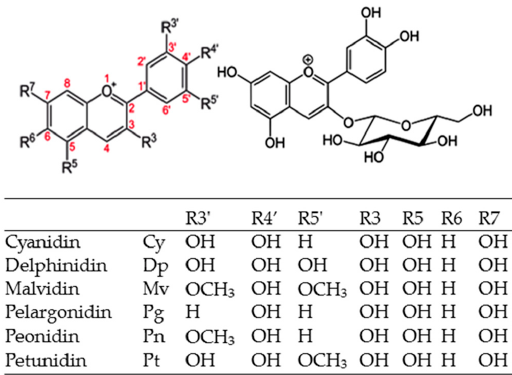
Figure 1. Structure of common anthocyanidins ( left ) and Cyanidin-3- O -glucoside (Cy3G; right ).